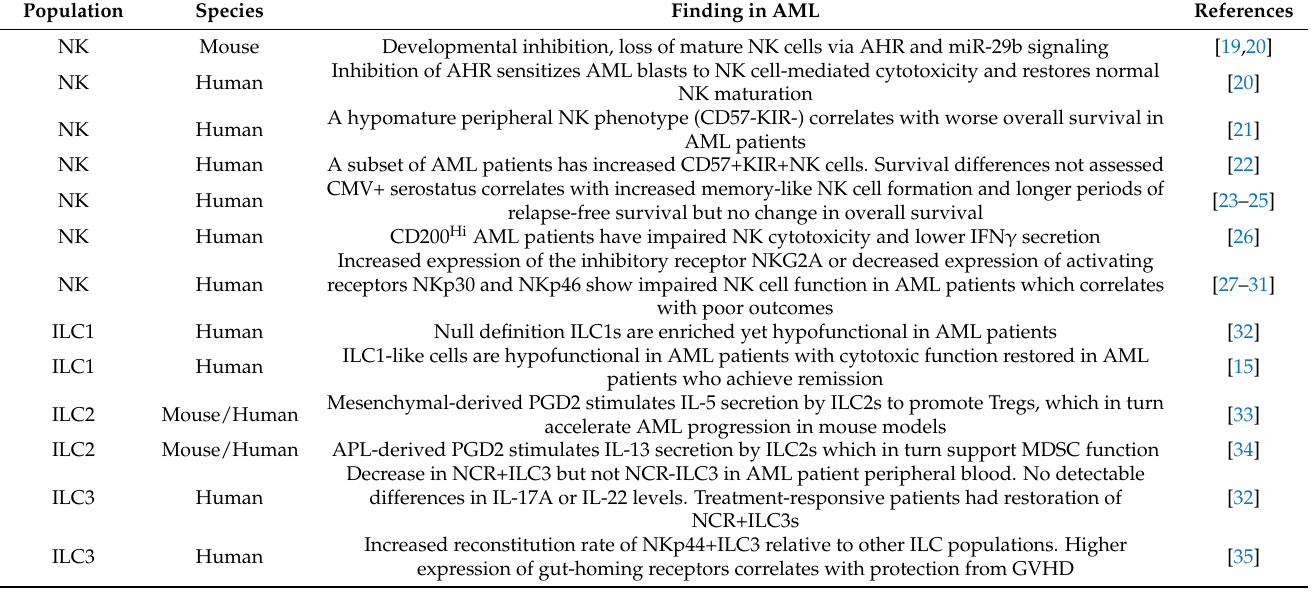
Table 1. Summary of Innate Lymphoid Cell (ILC) Population Findings in Acute Myeloid Leukemia (AML). Population Species Finding in